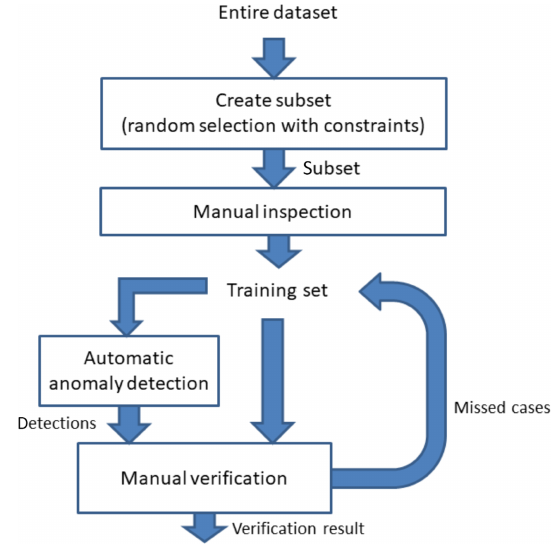
Figure 1. Approach for creating a training set, where a manually inspected image is corrected by